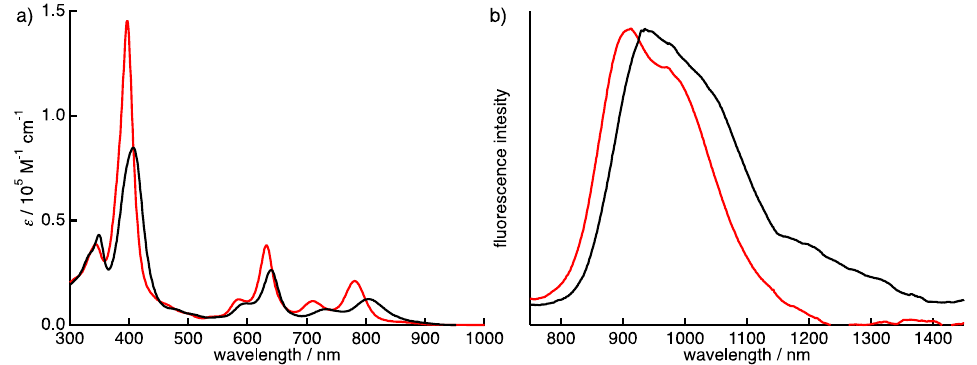
Figure 5. ( a ) Absorption and ( b ) fluorescence spectra of 1a-H 2 (black) and 1b-H 2 (red) in CH 2 Cl 2 . The